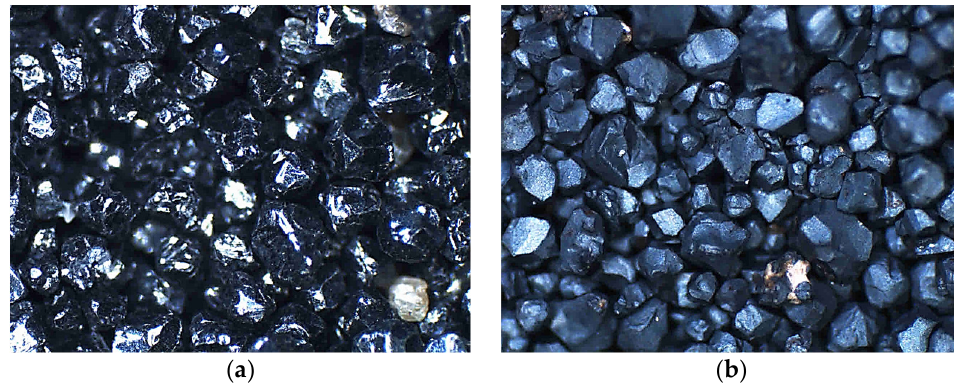
Figure 15. Microscopic images of surface of grain matrix: ( a ) initial chromite sand (mag. 50×); ( b ) chromite sand roasted at 1000 °C (mag. 50×).